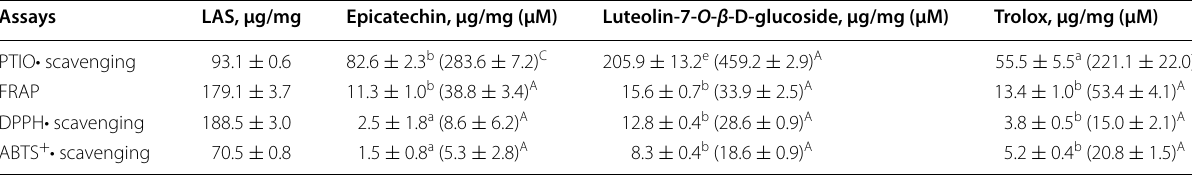
SD ( n 3). The linear regression was analyzed by Origin 6.0 professional ± =